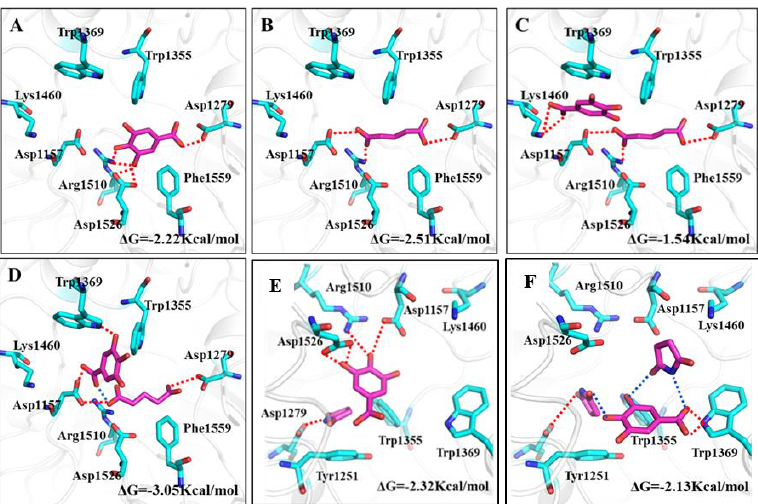
Figure 5. Binding patterns of GA-CCF systems with α -glucosidase. Amino acid residues and hydrogen bonding interaction in active cavity of α -glucosidase for ( A ) GA; ( B ) glutaric acid; ( C ) free GA and glutaric acid; ( D ) GA-glutaric acid complex; ( E ) free GA and succinimide; ( F ) GA-succinimide complex.